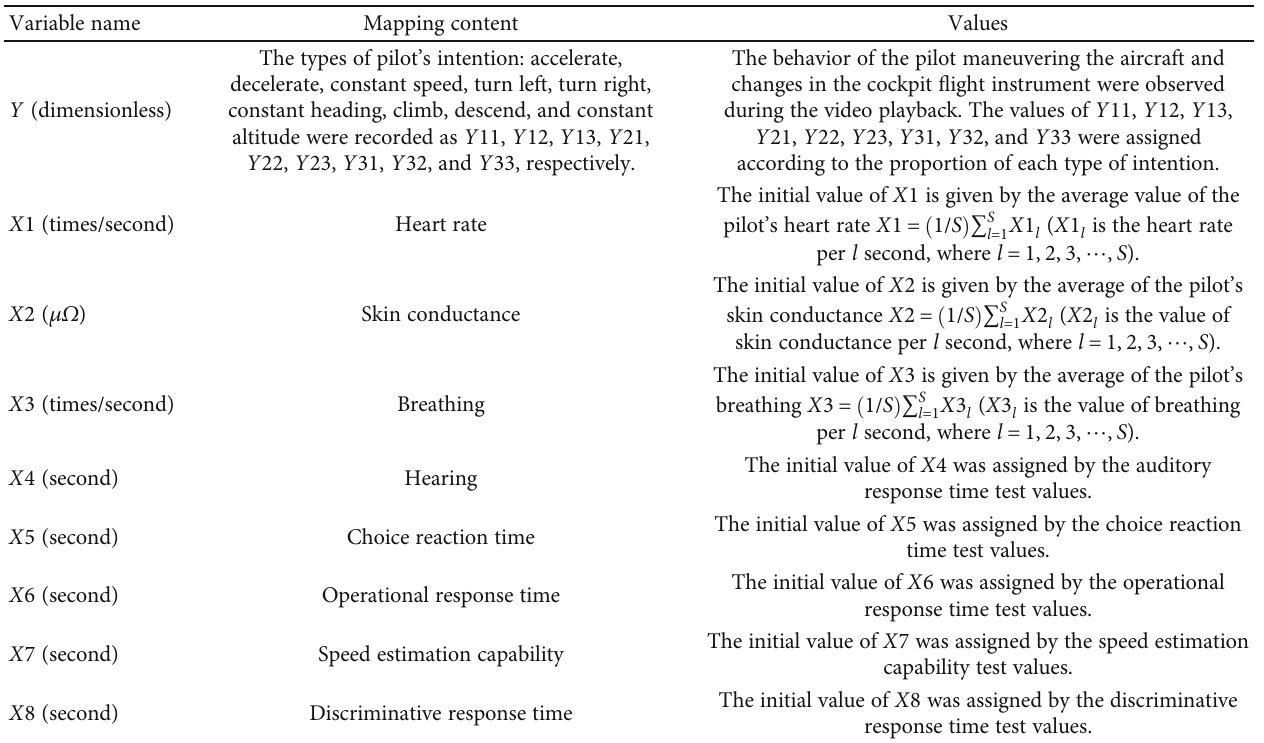
Table 3: Mapping content and value of each